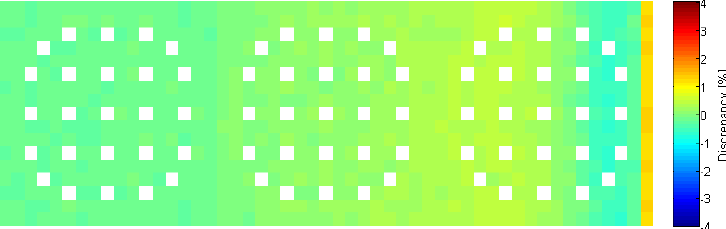
Figure 7. Axially averaged radial pin power error of Tortin using SERPENT cross sections and SERPENT reference